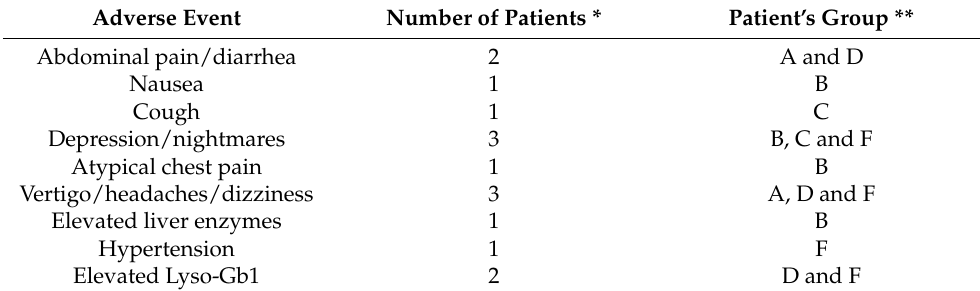
Table 2. Adverse events (AEs) associated with